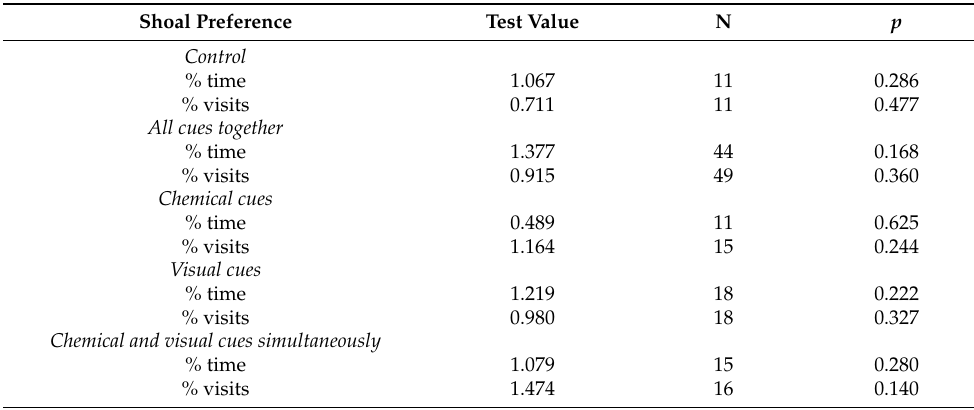
Table 2. Summary statistics for differences in percentage of time and visits to each stimulus shoal, according to the sensory cues under test (visual, chemical, chemical and visual simultaneously), using Wilcoxon matched-pairs signed-ranks; test value, sample size (N), and the p -value ( p